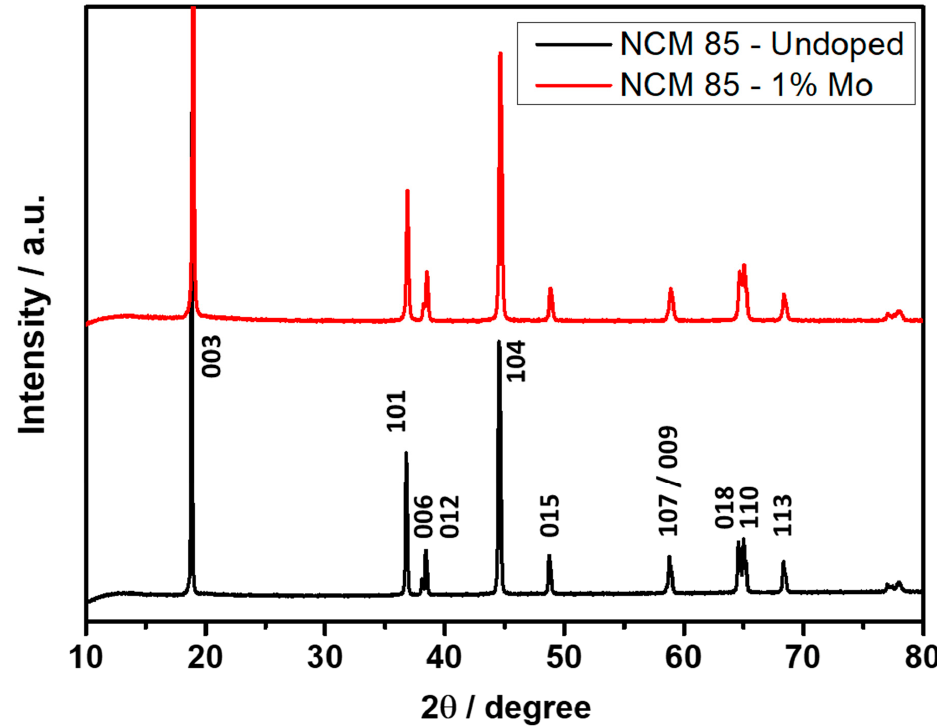
Figure 1. XRD patterns of NCM85 undoped and Mo-doped materials synthesized by solution-combustion method and annealed in a tubular furnace at 760 °C in pure oxygen for 6 h. The lattice a- and c -parameters, mean coherent domain size, cationic mixing (Ni 2+ in the Li-layer), and the calculated intensity ratios of 003, 104, and 012, and the 006 and 101 planes of these samples are presented in Table 2. Table 2. The lattice parameters a and c , mean coherent domain size, cation mixing (Ni 2+ /Li + ) and intensity ratios of 003, 104, and 012, and the 006 and 101 planes obtained from XRD patterns of NCM85 undoped and 1 at. % Mo-doped materials .